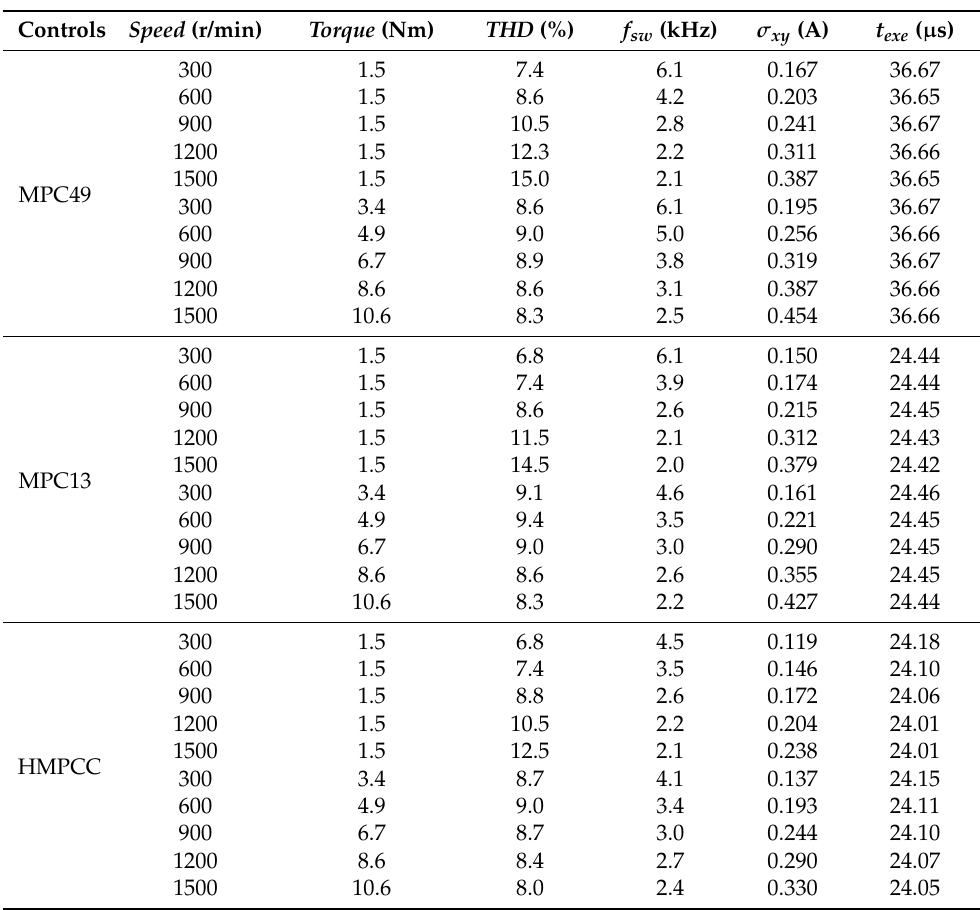
Table A2. Summary of the performance indicators for the control strategies applied to the asymmet- rical six-phase IM (Test